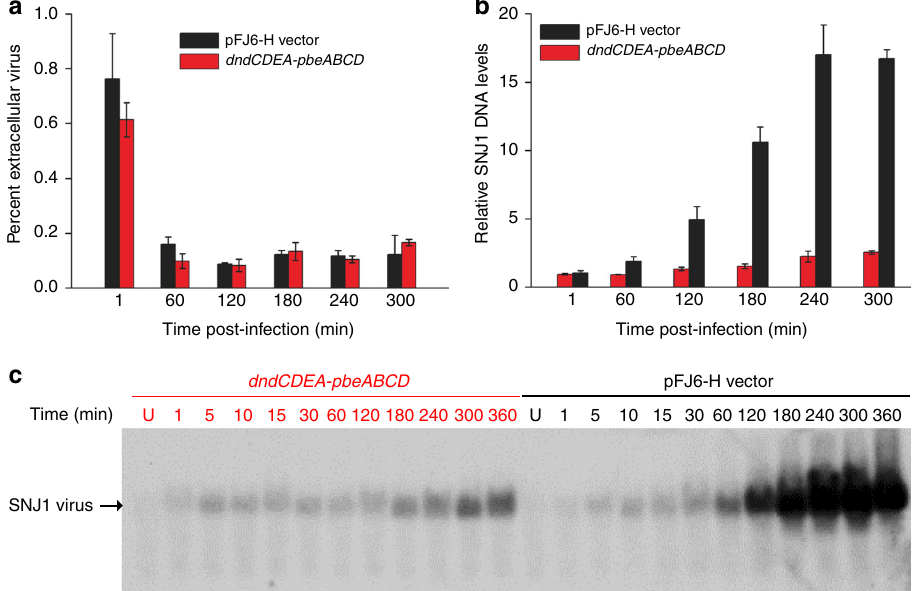
Fig. 5 Adsorption and DNA replication of the SNJ1 virus in CJ7-F cells expressing or lacking DndCDEA-PbeABCD. a Adsorption of SNJ1 to dndCDEA- pbeABCD -containing CJ7-F cells (red) is not impaired compared to that observed for CJ7-F cells containing the empty vector pFJ6-H (black). After the infection of logarithmic-stage cultures (OD600 = 0.3) with SNJ1 at an MOI = 1, samples were collected at 60-min intervals, and the extracellular (unabsorbed) viral concentration was measured and compared to the initial viral concentrations. The bars represent the means of three experiments, and the error bars represent the SD of the mean. b Real-time qPCR analysis to determine the replication ef fi ciency of the virus SNJ1 in CJ7-F cells expressing (red) or lacking (black) dndCDEA-pbeABCD . Primers amplifying repA and radA were used to determine the concentration of SNJ1 DNA and CJ7-F chromosomes, respectively. The 2 C T (radA) – C T (repA) method was used to determine the relative levels of SNJ1 DNA in CJ7-F hosts. c Southern blot analysis of the SNJ1 genome during the infection cycle. Numbers indicate the time (min) following infection. A probe was designed corresponding to positions 9243 – 9732 nt in the SNJ1 genome. Source data are provided as a Source Data fi